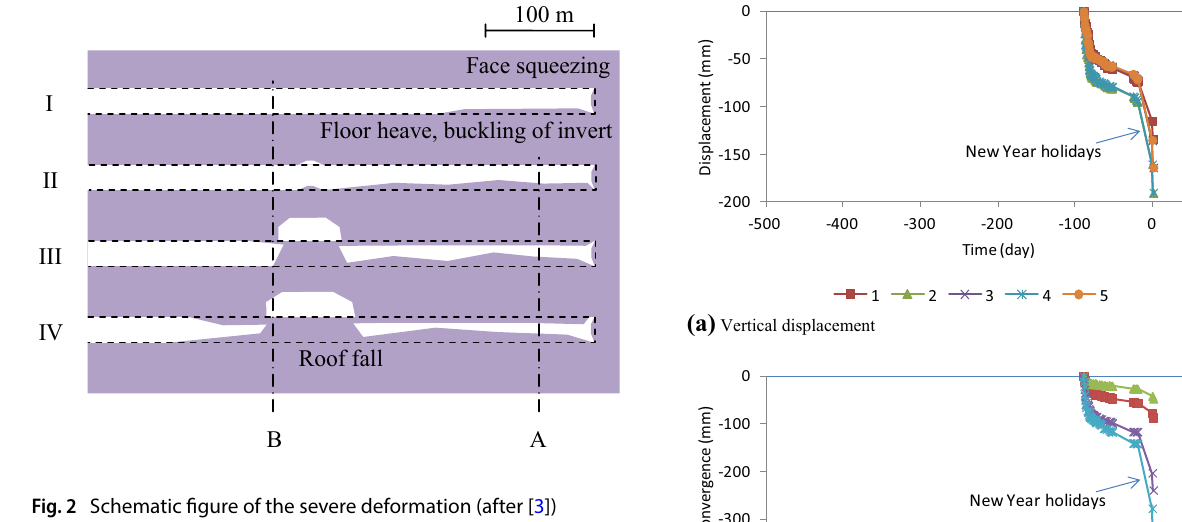
Fig. 2 Schematic figure of the severe deformation (after [3])